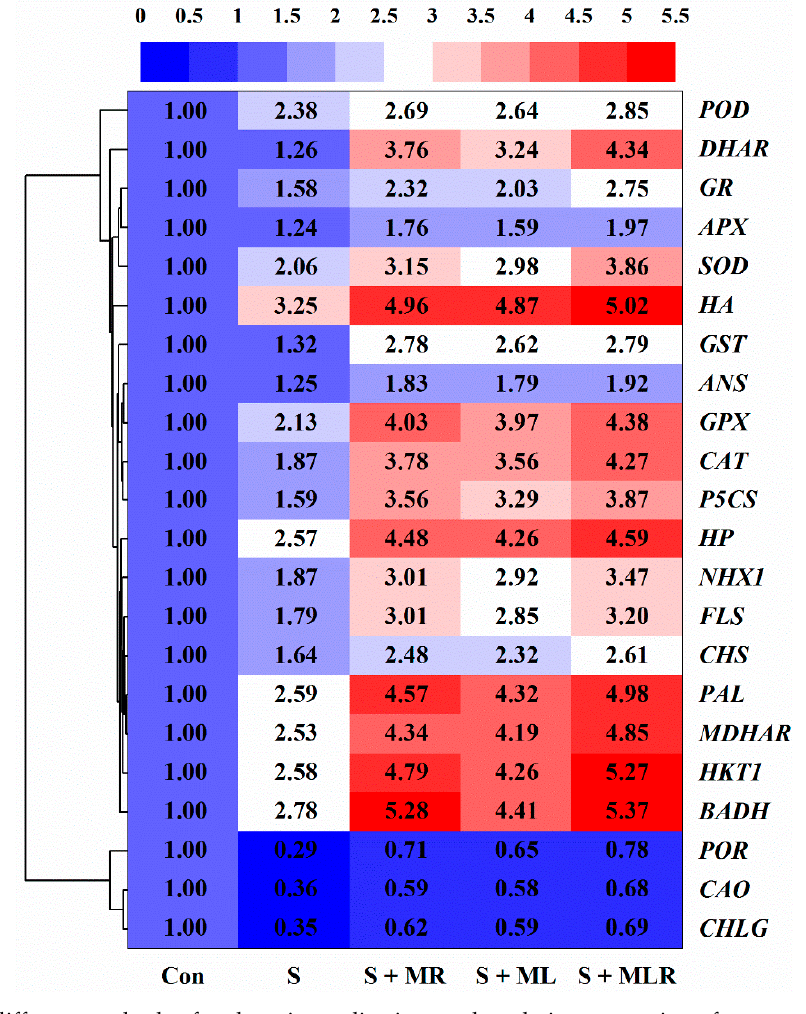
Figure 8. Effect of different methods of melatonin application on the relative expression of genes related to chlorophyll synthesis, osmolyte synthesis, ion transport, H + -pumps, antioxidant enzymes, and secondary metabolism synthesis of sugar beet seedlings under salt stress. Con, control treatment; S, salt stress treatment; S + MR, salt stress treatment + root application of melatonin; S + ML, salt stress treatment + foliar application of melatonin; S + MRL, salt stress treatment + combined root and foliar applications of melatonin. The intensity of gene expression extends from blue (low) to red (high).